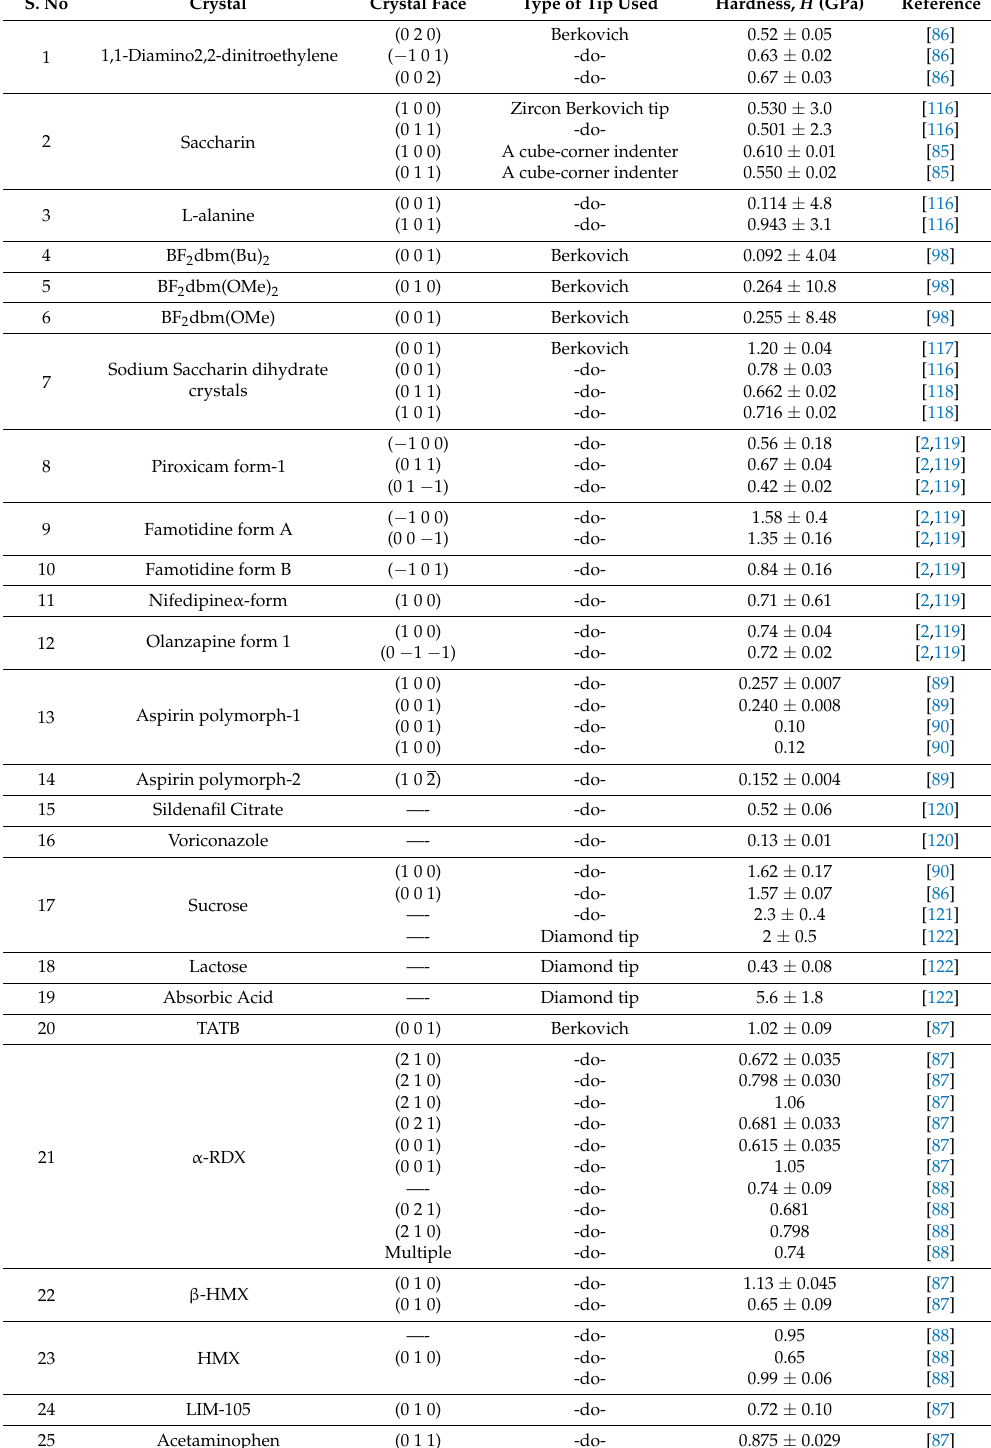
Table 3. The variety of organic crystals used by various research groups for nanoindentation study and their indentation hardness